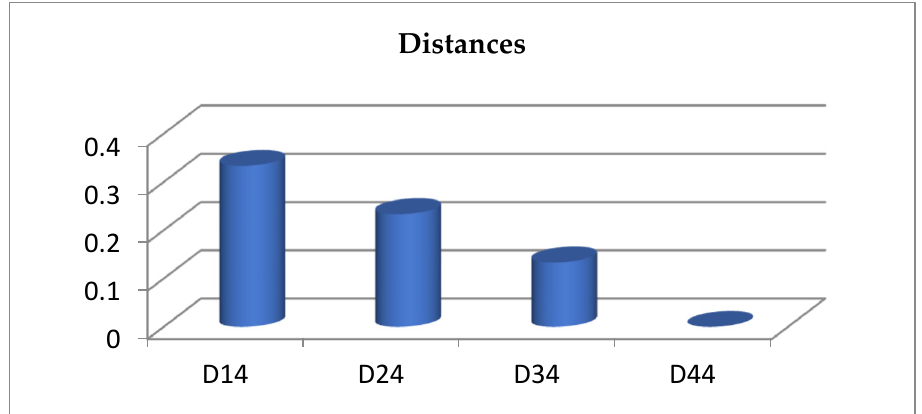
B . Figure 1. Distances from the 4th point of the SVNS B